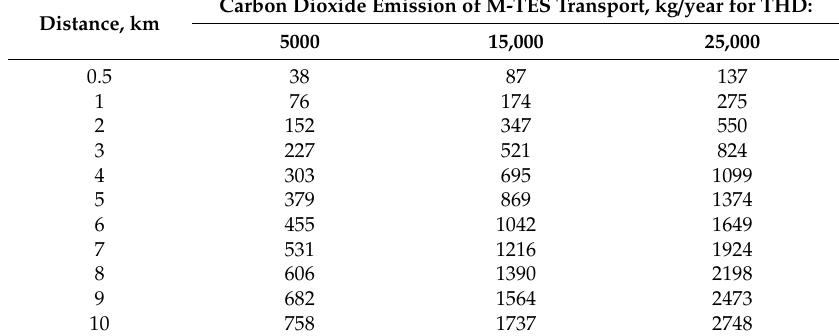
Table 2. Carbon dioxide emission of M-TES transport as a function of distance between building and M-TES load base, and THD. Source: own